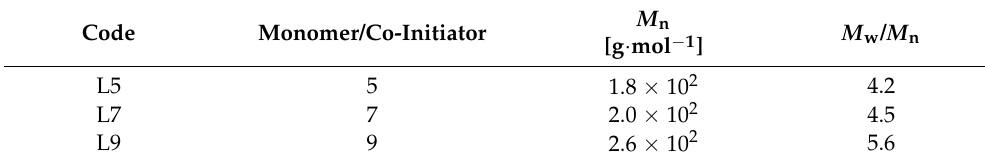
Table 1. Molecular characteristics of synthesized OLLA.